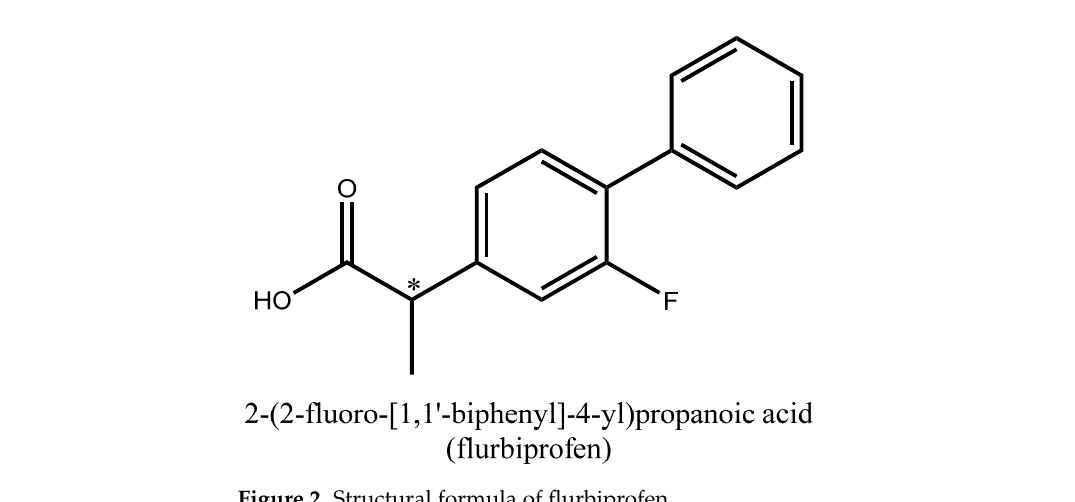
Figure 2. Structural formula of flurbiprofen.